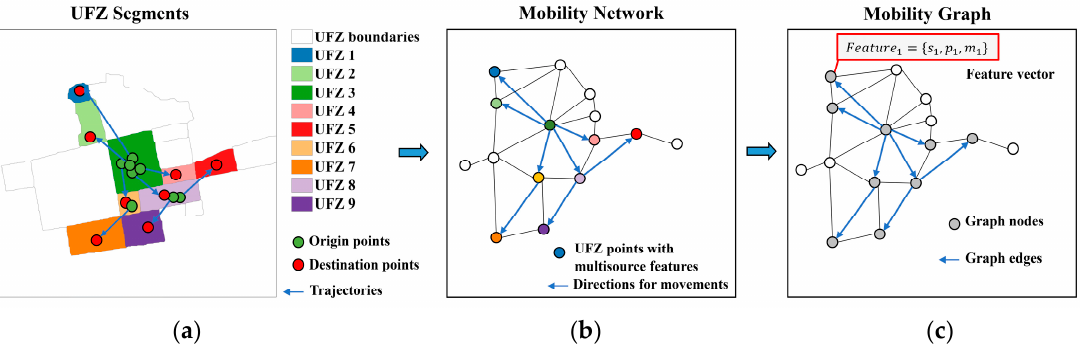
Figure 6. UFZ mobility graph generation: ( a ) UFZs contain O/D points and effective trajectories; ( b ) mobility network constructed based on UFZ points and movements; ( c ) mobility graphs with multisource feature embeddings transformed from mobility